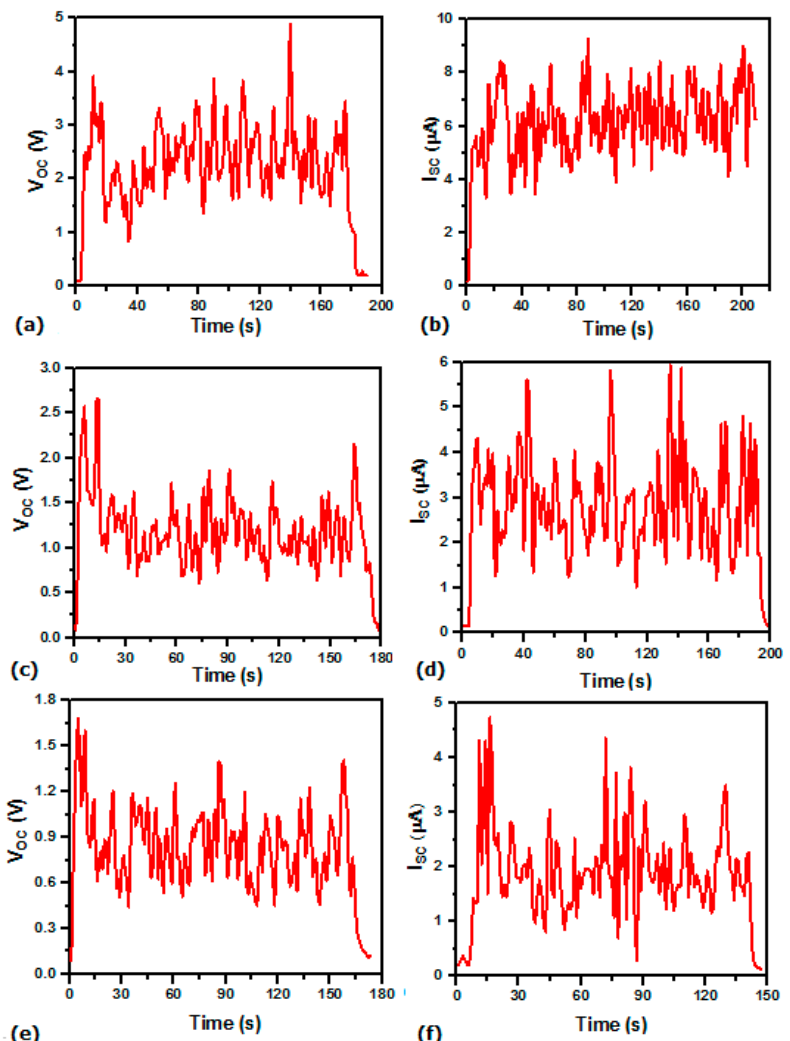
Figure 6. Electrical output of the piezo films: ( a ) rectified open circuit voltage at wind speeds of 7–8 m/s ( b ) short-circuit current at wind speeds of 7–8 m/s ( c ) rectified open circuit voltage at wind speeds of 5–6 m/s ( d ) short-circuit current at wind speeds of 5–6 m/s ( e ) rectified open circuit voltage at wind speeds of 3–4 m/s ( f ) short-circuit current at wind speeds of 3–4 m/s.